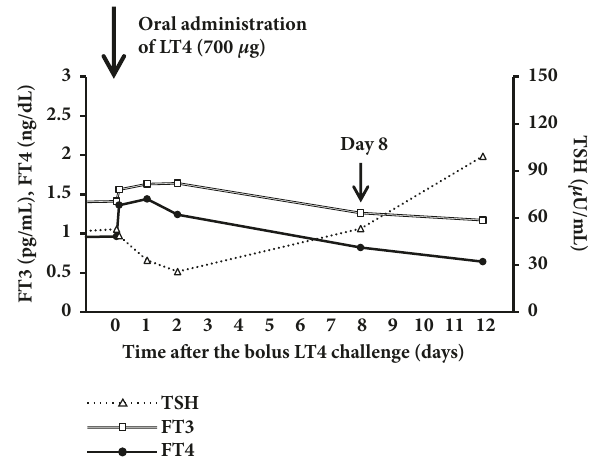
Figure 5: Serum thyroid hormone and TSH levels after the oral administration of a single bolus of LT4 (700 𝜇 g) . Eight days after the administration, serum FT4 and FT3 levels were 0.82 ng/dL and 1.26 pg/mL, respectively. Her serum TSH levels were 53.1 𝜇